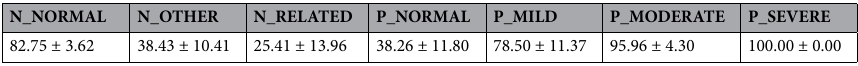
Table 6. Accuracy results by category on COVID-SC.